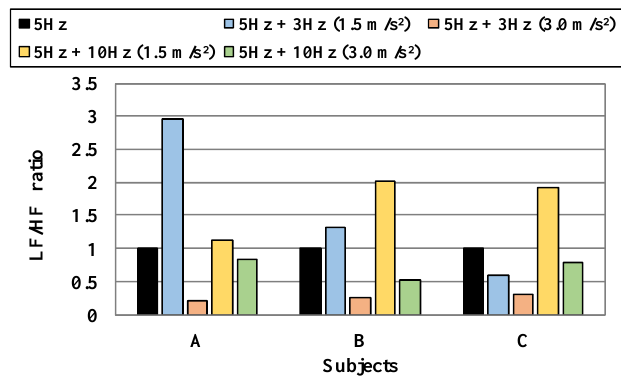
Figure 12. LF/HF values in masking of vibration.